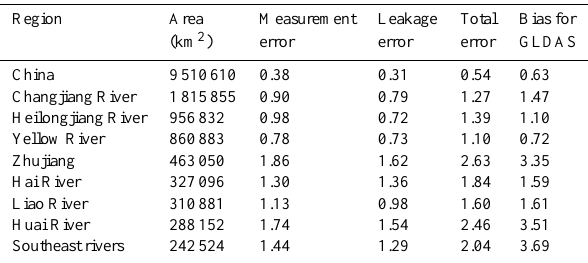
Table 4. Error statistics of regionally averaged TWS (unit: cm). Region